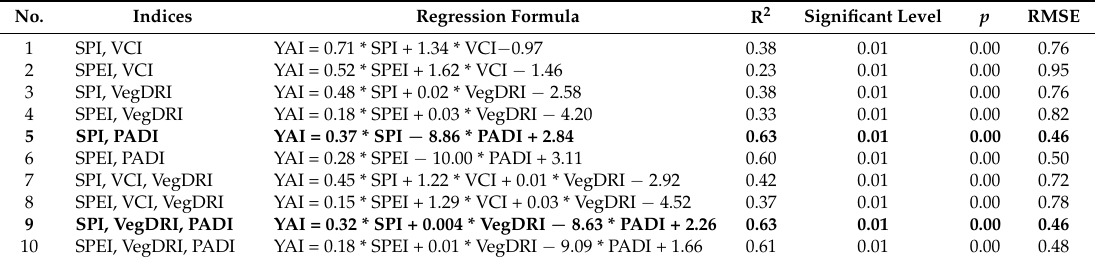
Table 6. Multi-linear regression analysis between representative drought indices and yield loss. One star symbol (*) represents the multiplication function. Regression size of 281 was used here.